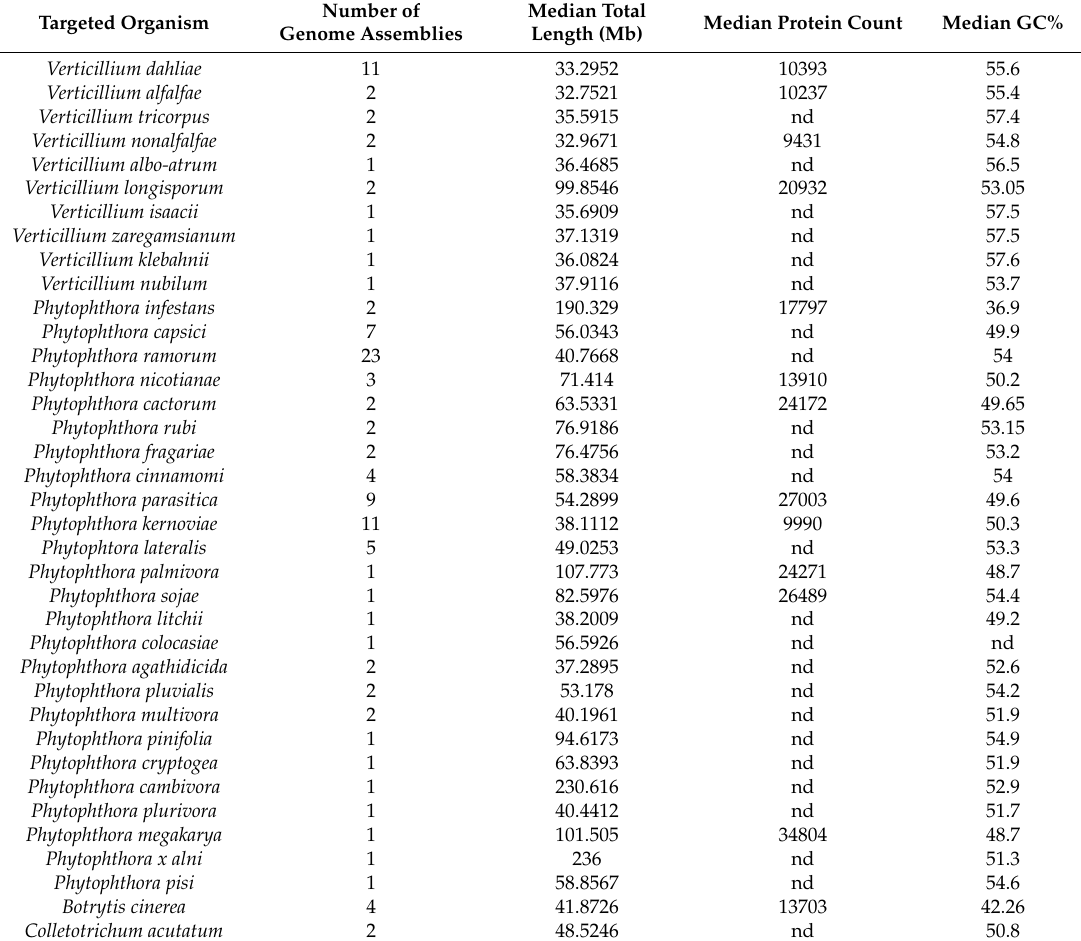
Table 1. Sequenced genomes of fungal pathogens from NCBI genome